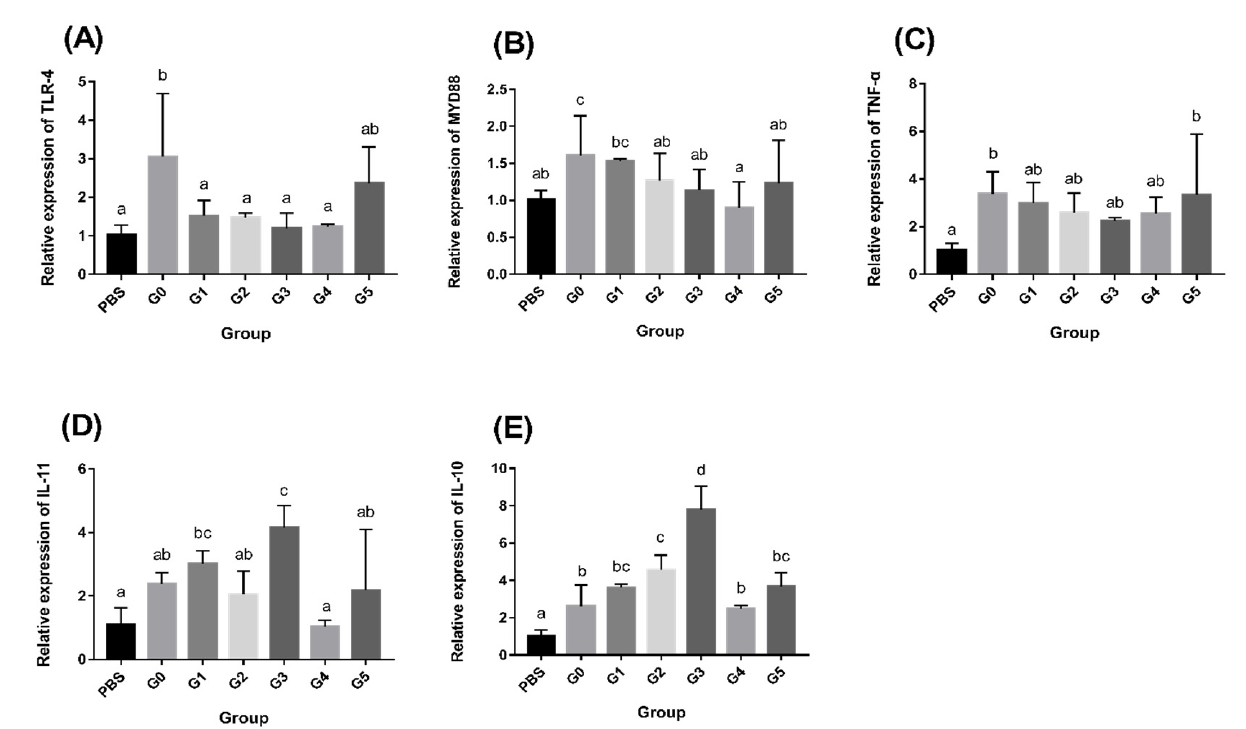
Figure 5. Expression of intestinal immunity-related genes following Aeromonas hydrophila infection. ( A ) Relative expression of TLR-4 ; ( B ) Relative expression of MYD88 ; ( C ) Relative expression of TNF- α ; ( D ) Relative expression of IL-11 ; and ( E ) Relative expression of IL-10 . The values represent the means with standard errors ( n = 3). Values which do not have a common superscript differ signifi- cantly ( p < 0.05).